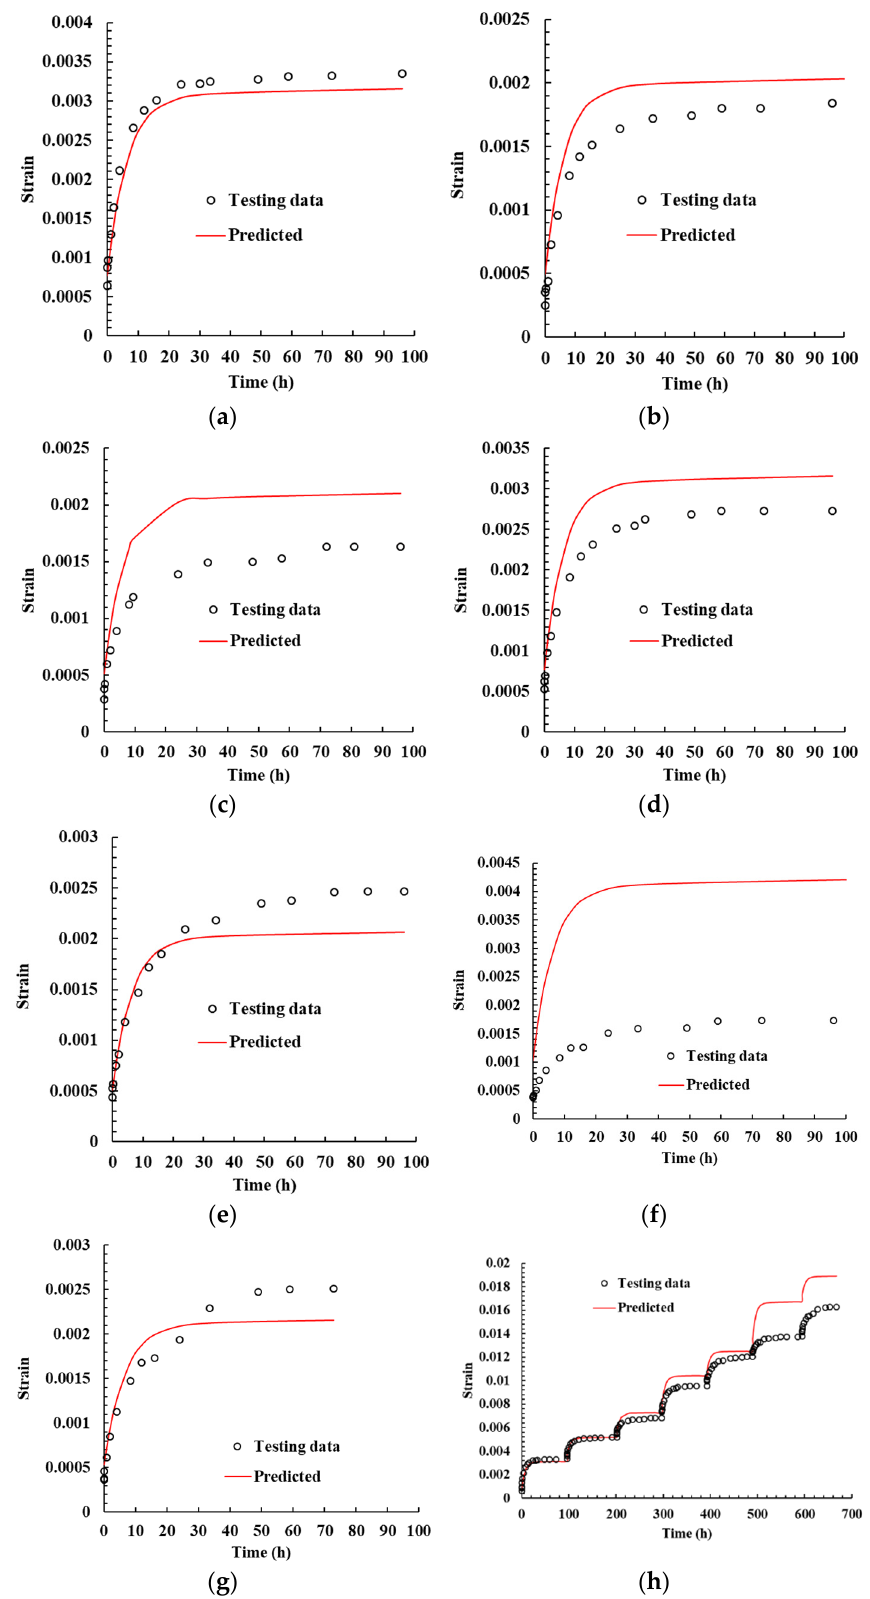
Figure 16. The curve comparison between test data and values predicted by the obtained rheological parameters using the Burgers model: ( a ) 0.9 MPa, ( b ) 1.48 MPa, ( c ) 2.08 MPa, ( d ) 2.98 MPa, ( e ) 3.57 MPa, ( f ) 4.77 MPa, ( g ) 5.39 MPa, and ( h ) predicted curve based on the full test